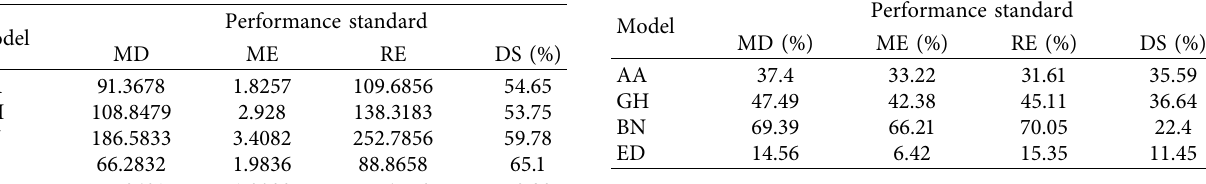
Table 4: Percentage improvement in performance compared to other